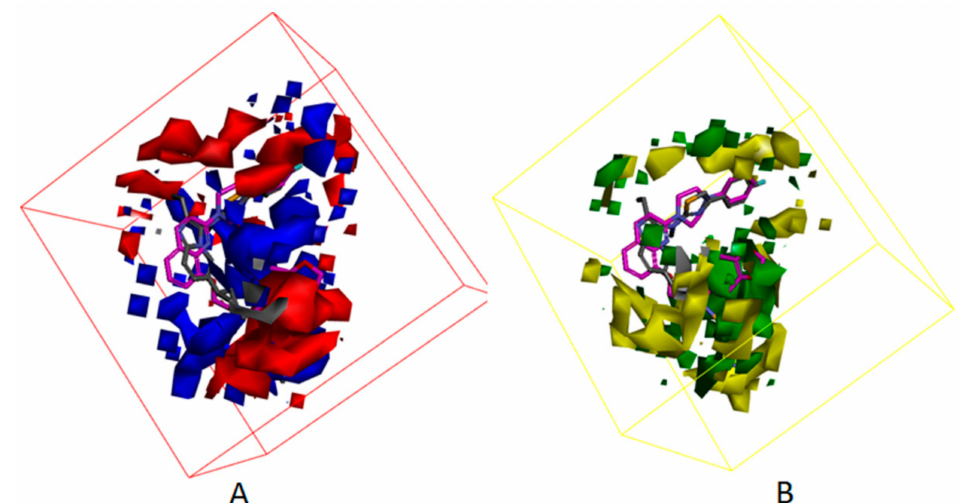
Figure 13. The mappings of cpd4 with isosurface-EP (–, red; + , blue) ( A ), isosurface-VMD (–, yellow; + , green) ( B ) grids. cpd4 is presented in purple stick form. Compound 7HR complexed with autotaxin is also shown for comparison (in gray stick